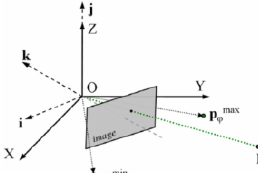
Figure 3. Definition of coordinate systems (Meierhold et al.,